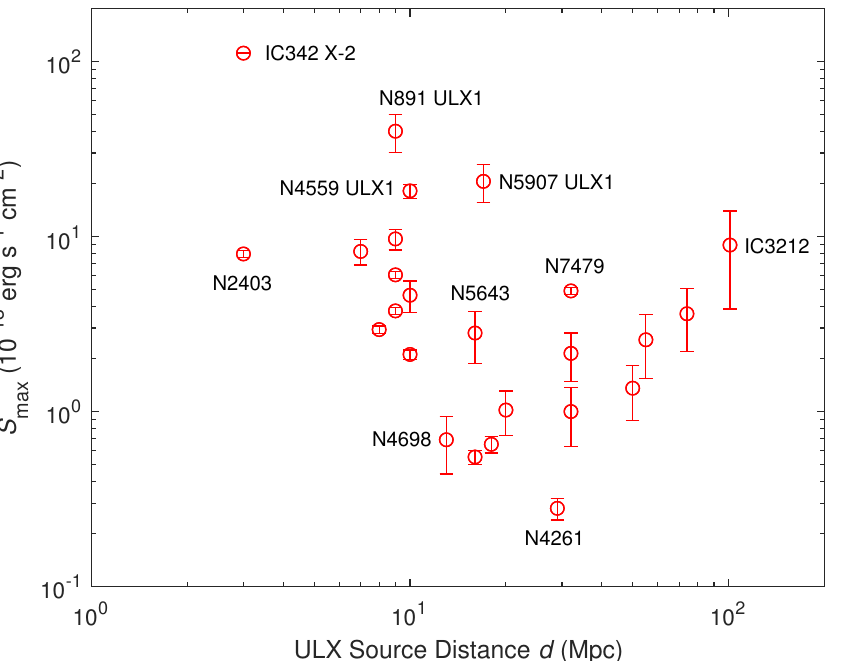
Figure 11. Maximum X-ray fluxes of the ULX sources from ULX data set 1 versus distance d in Mpc [1]. The majority of these sources radiate below a flux level of S max = 2 × 10 − 12 erg s − 1 cm − 2 , which is nothing to brag about, despite their enormous distances that reach as far out as 101